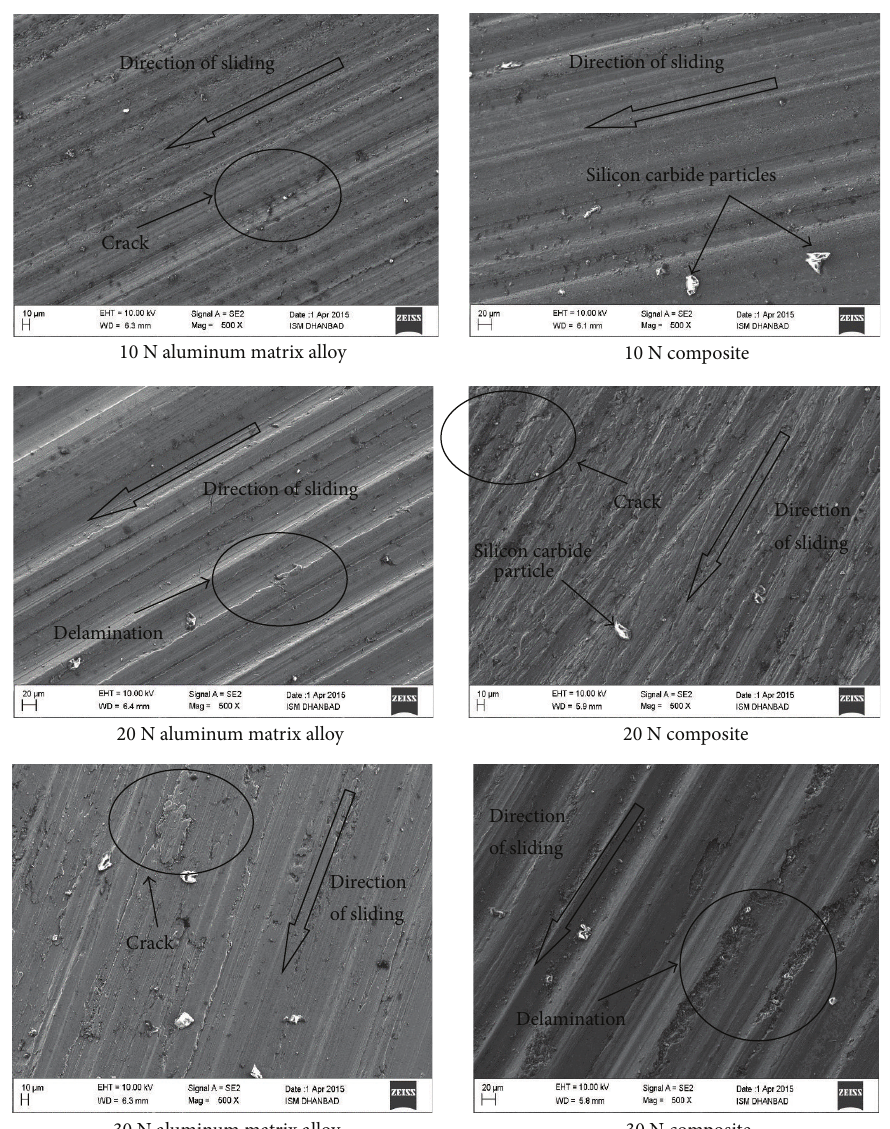
Figure 8: FESEM of worn surfaces at different loads with sliding speeds 3.77 m/s under dry condition.